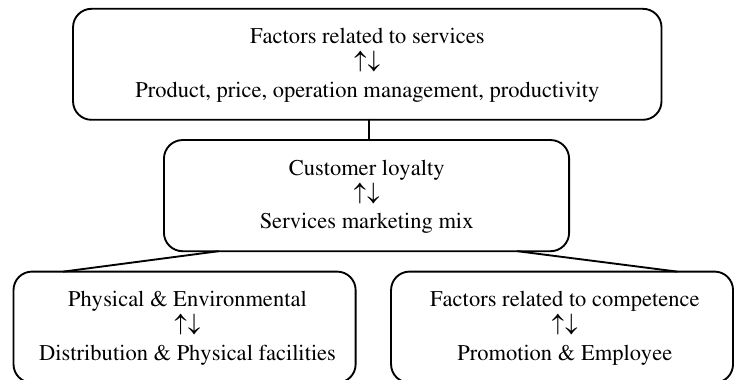
Fig. 3. Conceptual model for services marketing mix and effective factors on customer satisfaction relation (Davis-Srameck, Mentzer& Sank,